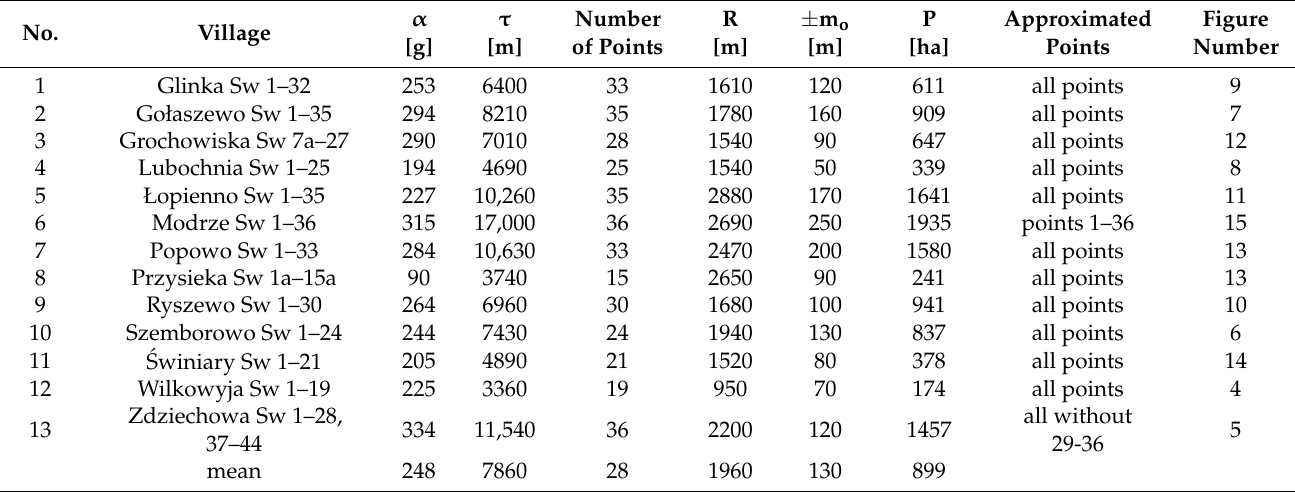
Symbols: α —central angle corresponding to the boundary arc (calculated from coordinates), τ —length of the border’s arc (calculated from the radius and the central angle), l. point—number of points assigned at the boundary, R—radius of the studied boundary approximating circle, ± m o —position error of the circle’s center (arc), P—area of the circular